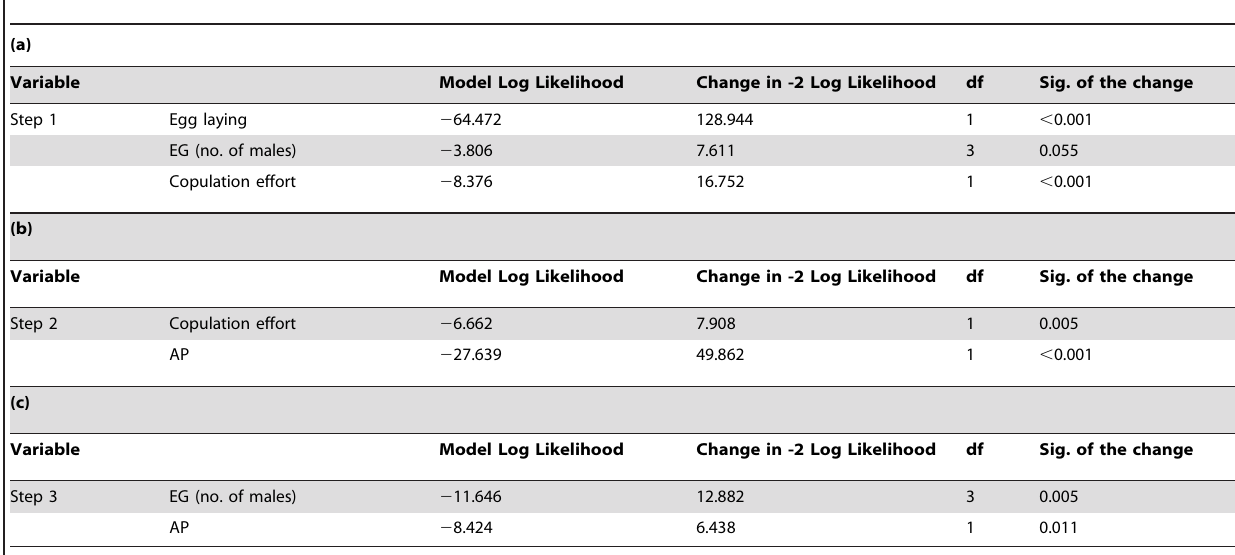
Table 2. Results from conditional backward logistic regressions testing factors that significantly affected (a) occurrence of amorphous plug (AP, independent variables: number of males with which a female copulated (experimental group; EG), egg-laying and copulation effort); (b) occurrence of egg-laying (independent variables: number of males with which a female copulated (EG), AP formation and copulation effort); and (c) molting in adulthood (independent variables: number of males with which a female copulated (EG), AP formation, egg laying, copulation effort and